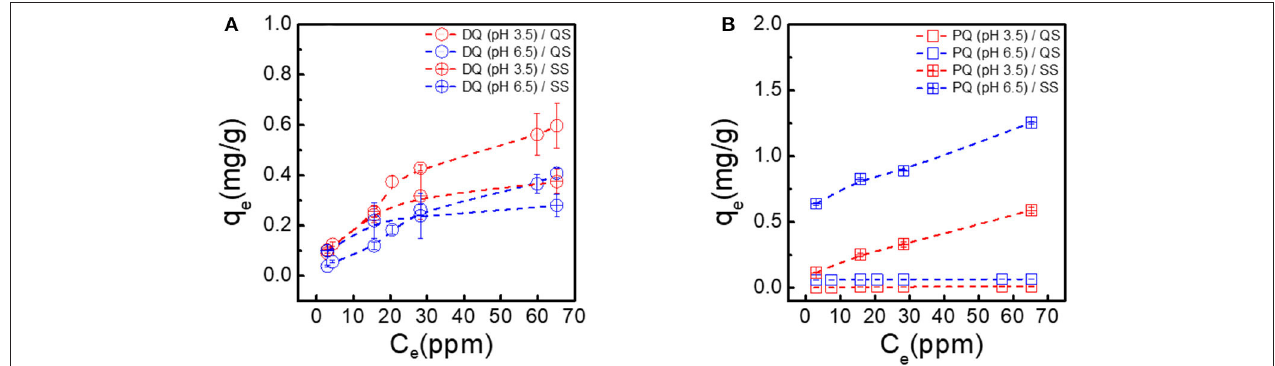
FIGURE 2 | Freundlich adsorption isotherms on clean quartz sand (QS) and silanized sand (SS) for (A) DQ ( ◦ ) and (B) PQ ( (cid:3) ) dissolved in KCl electrolyte adjusted at two pH conditions, pH 3.5 and pH 6.5. Dashed lines are included as eye guide, and error bars represent 95% confidence intervals.